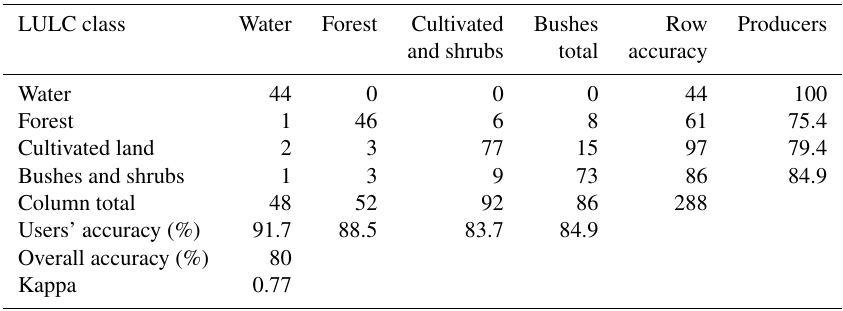
Table 4. Confusion (error) matrix for the 2010 land-use and land-cover classification map. LULC class Water Forest Cultivated Bushes Row and shrubs